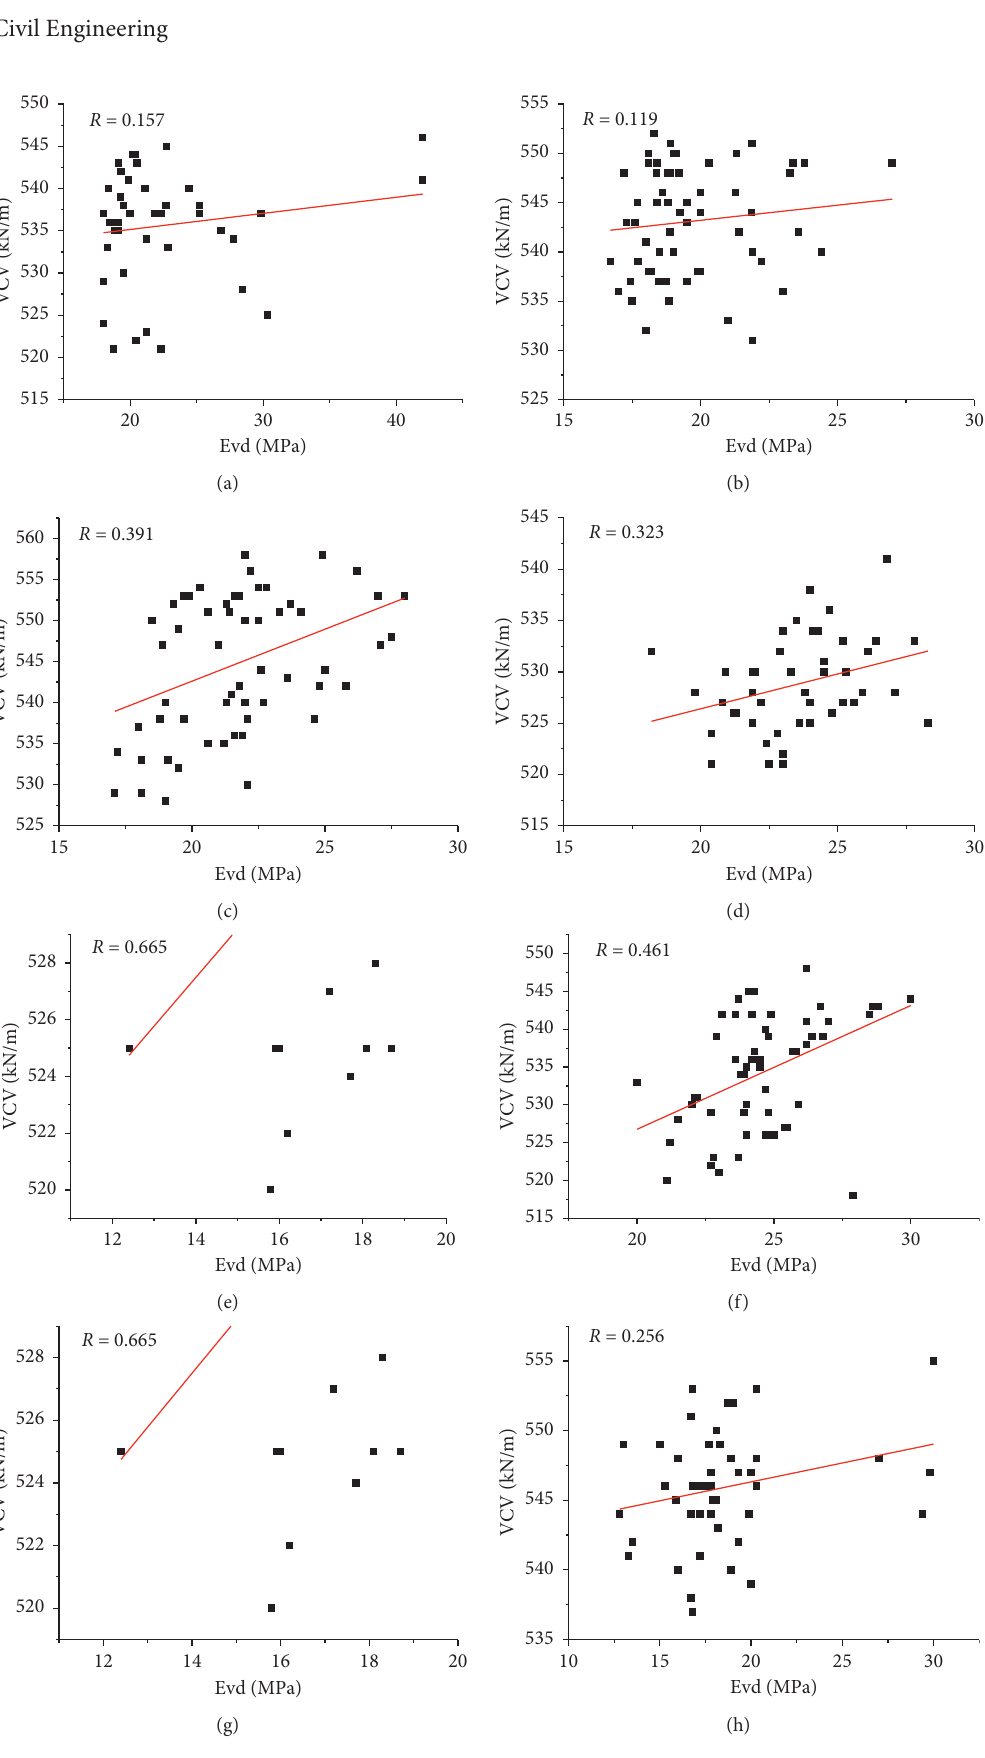
Figure 5: E vd values and their corresponding VCV values all the measurement points. (a) WC 1; (b) WC 2; (c) WC 3; (d) WC 4; (e) WC 5; (f) WC 6; (g) WC 7; (h) WC